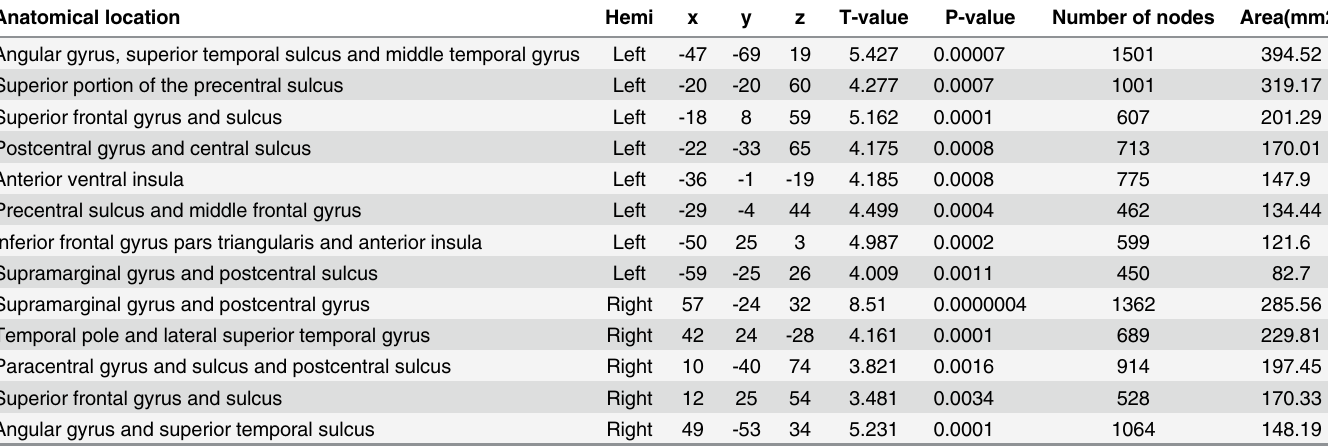
All coordinates are in Talairach space and represent the maximum surface node value for each of the cluster (minimum cluster size: 437 contiguous surface nodes, each signi fi cant at p <